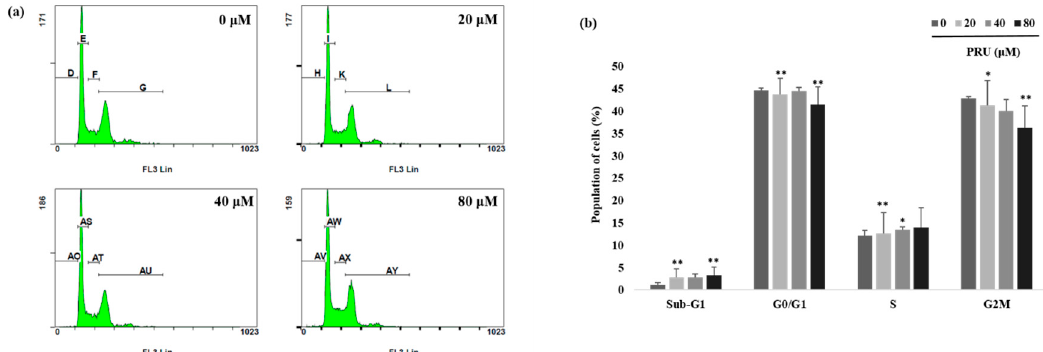
Figure 3. Analysis of cell cycle by flow cytometry. ( a ) The effect of PRU on cell cycle arrest was examined by flow cytometry analysis, AGS cells were treated with PRU at indicated concentrations (20, 40, and 80 µ M) for 24 h. Followed by propidium iodide (PI) staining and subjected to flow cytometer analysis. ( b ) The population of cells identified on different phases of the cell cycle were represented graphically. Values are given as the mean ± standard error of the mean (SEM) of three independent experiments. * p < 0.05 vs. control, ** p < 0.01 vs. control, *** p < 0.001 vs. control.